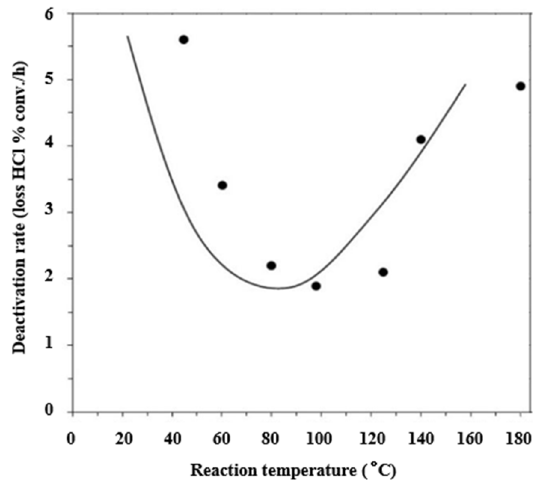
Figure 10. Effect of reaction temperature on rate of Au 3+ catalyst deactivation [78].